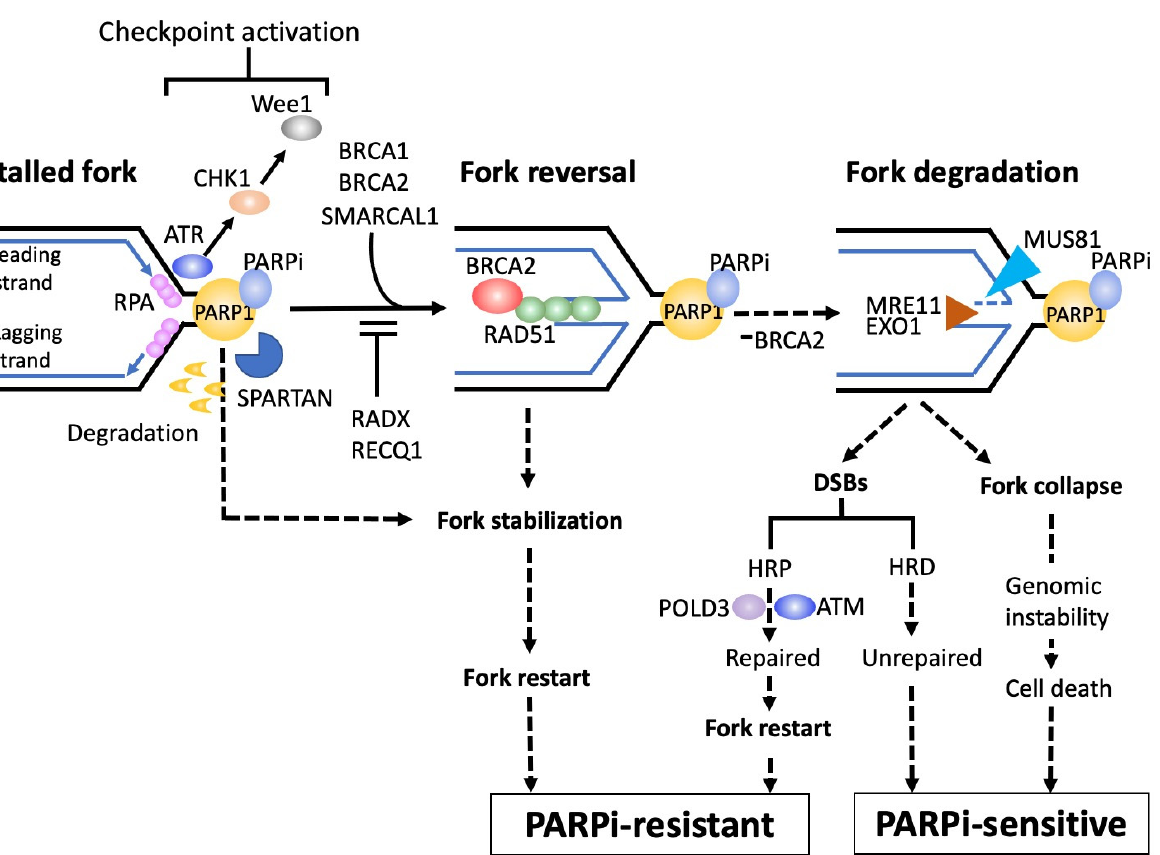
Figure 2. Integrity of fork stabilization on PARP trapping determines PARPi sensitivity. PARP trapping induces stalled replication forks, triggering a series of replication stress responses. After fork stalling, ssDNAs are generated in both lagging and leading strands, and are coated by RPA. The ssDNA-RPA complex then induces activation of the replication checkpoint via ATR and subsequent CHK1 and Wee1 activation, arresting the cell cycle to allow the time necessary to relieve the stalled fork and protect against fork collapse. RPA is then replaced by RAD51, which promotes fork reversal, a phenomenon to bypass and unwind the stalled fork, and the BRCA2-RAD51 axis plays pivotal roles in stabilizing fork reversal. When BRCA1/2 is defective, MRE11 and/or EXO1 nucleases destabilize stalled forks, resulting in accumulated DSBs or fork collapse, leading to PARPi sensitivity. Spartan (SPRTN) facilitates the repair of bulky PARP1-DNA complexes via proteolytic digestion to ensure fork progression, conferring PARPi resistance. Thus, the integrity of fork stabilization on PARP trapping plays major roles in determining sensitivity to PARPis, and nuclear factors that are involved in this integrity can be potential targets to overcome PARPi resistance. These acronyms are defined as follows: ATM, ataxia-telangiectasia mutated protein kinase; ATR, ataxia-telangiectasia and rad3 related protein kinase; CHK1, checkpoint kinase 1; DSB, double strand break; EXO1, exonuclease 1; HRD, homologous recombination deficiency; HRP, homologous recombination proficiency; MRE11, meiotic recombination 11; MUS81, methyl methanesulfonate and ultraviolet-sensitive gene; POLD3, 3rd subunit of DNA polymerase δ ; RADX, RPA-related RAD51-antagonist on X-chromosome; RECQ1, ATP-dependent DNA helicase Q1; RPA, replication protein A; SMARCAL1, SWI/SNF-related, matrix- associated, actin-dependent regulator of chromatin subfamily A-like 1; Wee1, Wee1 tyrosine kinase. A stalled replication fork is very unstable and is exposed to the risk of fork collapse. There are rescue processes for stalled replication forks [32]. After fork stalling, ssDNAs are generated by polymerase-helicase uncoupling in both lagging and leading